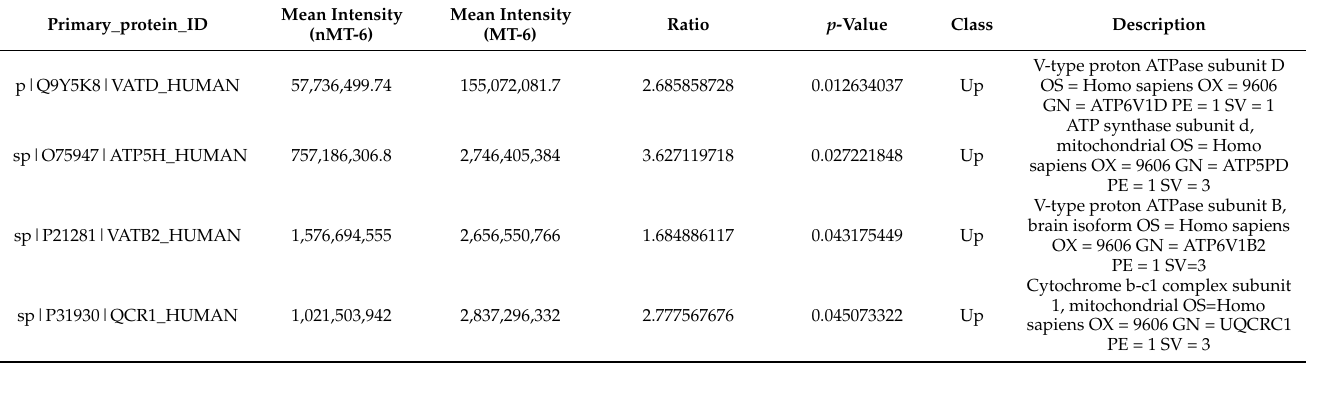
Table 3. Statistical table of the number of differential proteins related to oxidative phosphorylation pathway between nMC-6 group and MC-6 group.